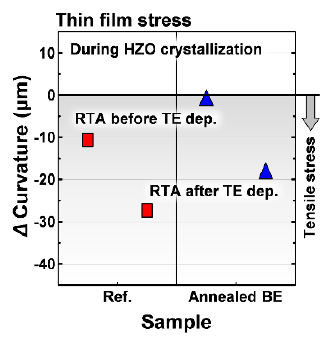
Figure 2. Variations in the radius of the curvature of the 100 mm wafers during HZO crystallization.